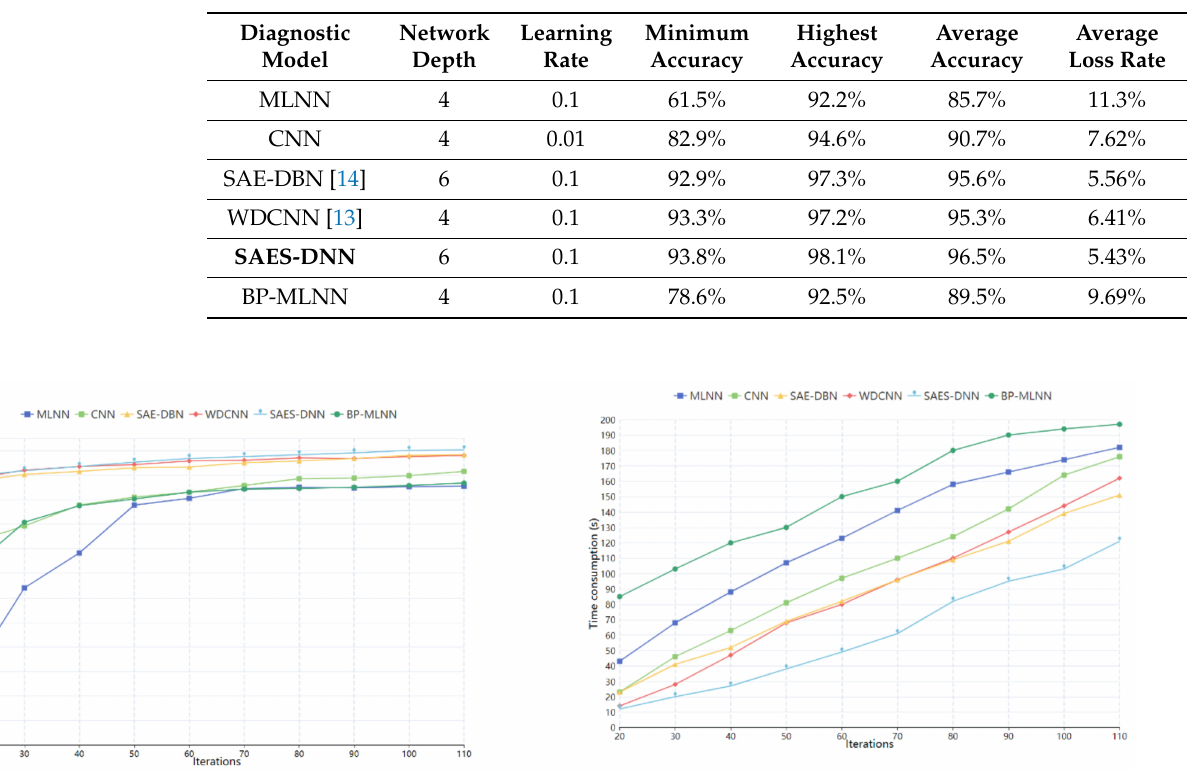
Table 1. Calculation of the training accuracy of different models in the same data set.